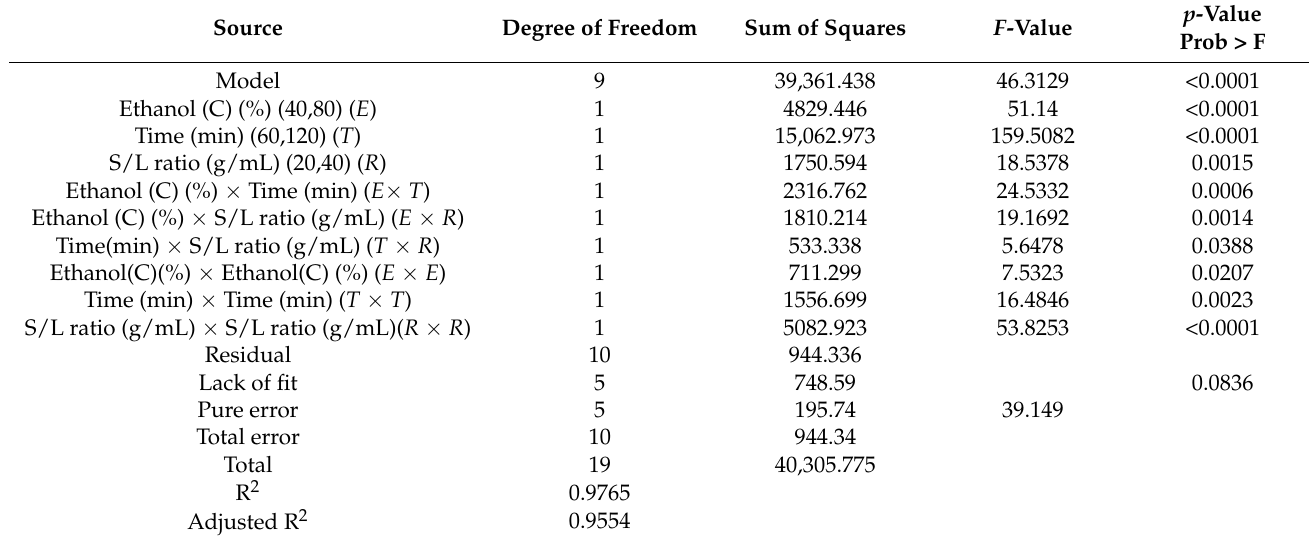
Table 3. Analysis of the variance of the experimental results of PP